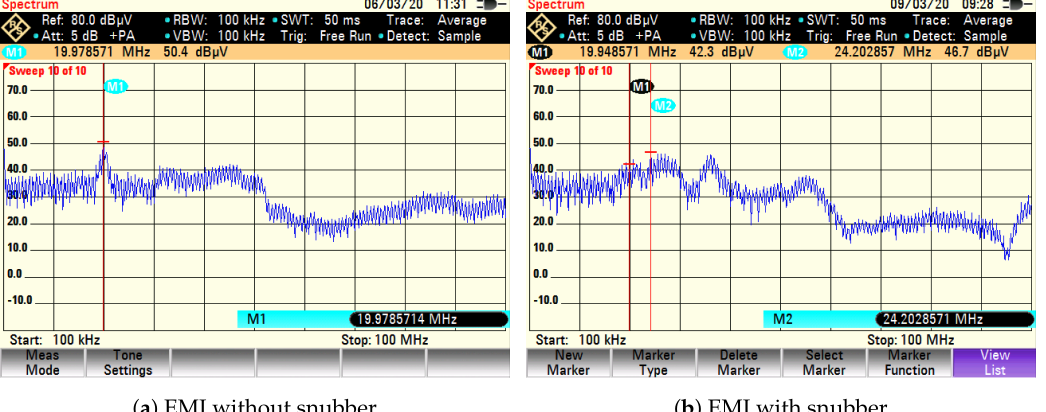
Figure 19. EMI for the SEPIC converter “ V in = 22